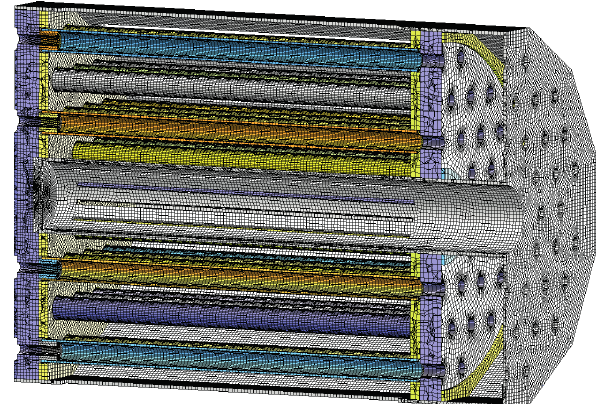
Figure 3: Hexagonal mSOFC stack design with air distributor, manifolds and